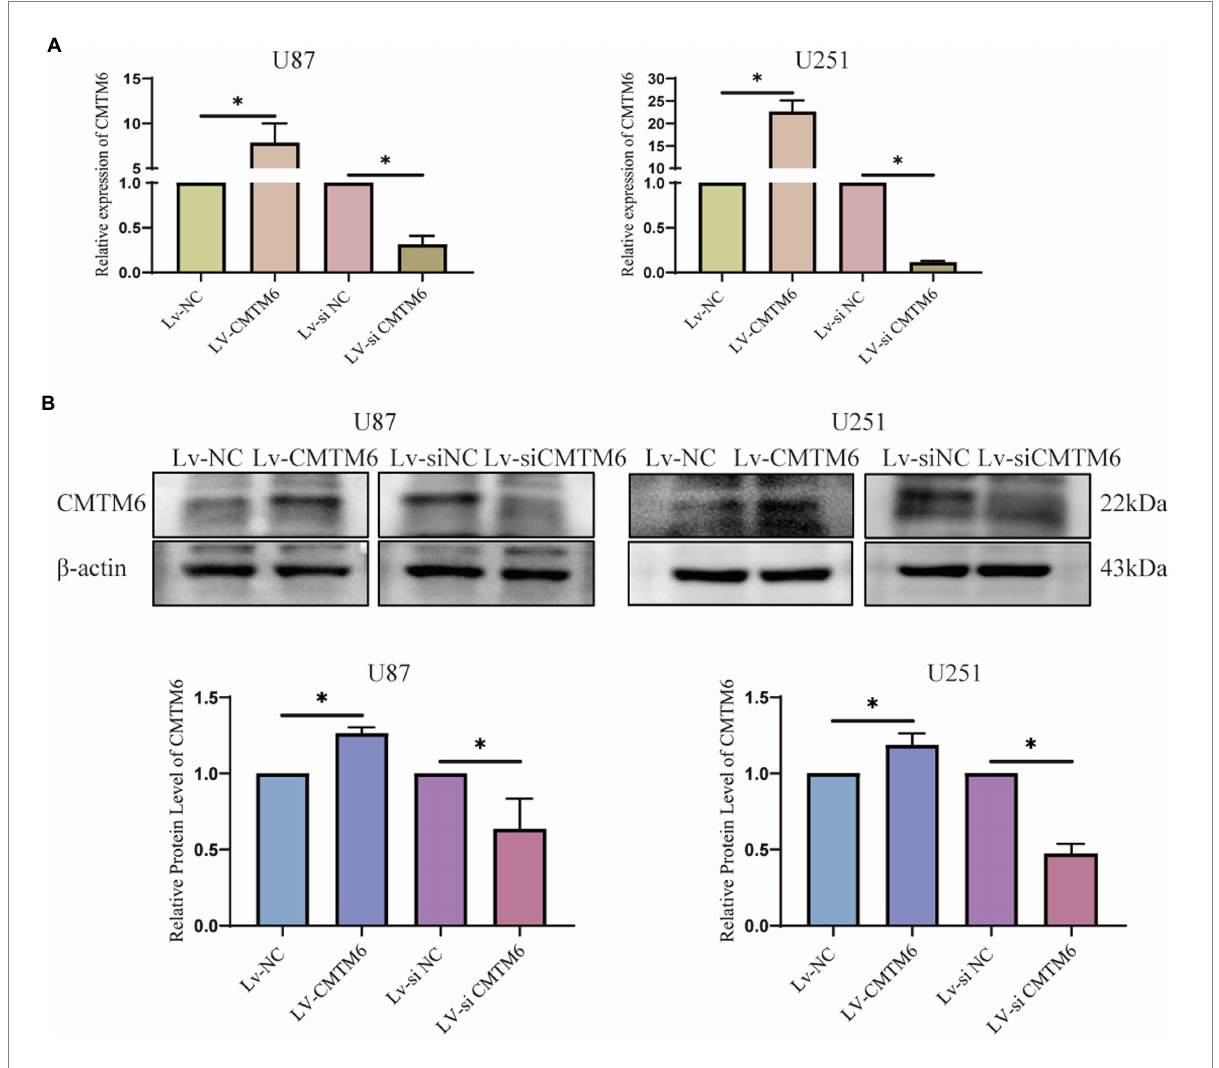
FIGURE 6 RNA and protein expression of CMTM6. (A) RNA level expression analysis of CMTM6 expression after up and down regulation of CMTM6. (B) Western blot and result analysis of CMTM6 expression after up and down regulation of CMTM6. * p <